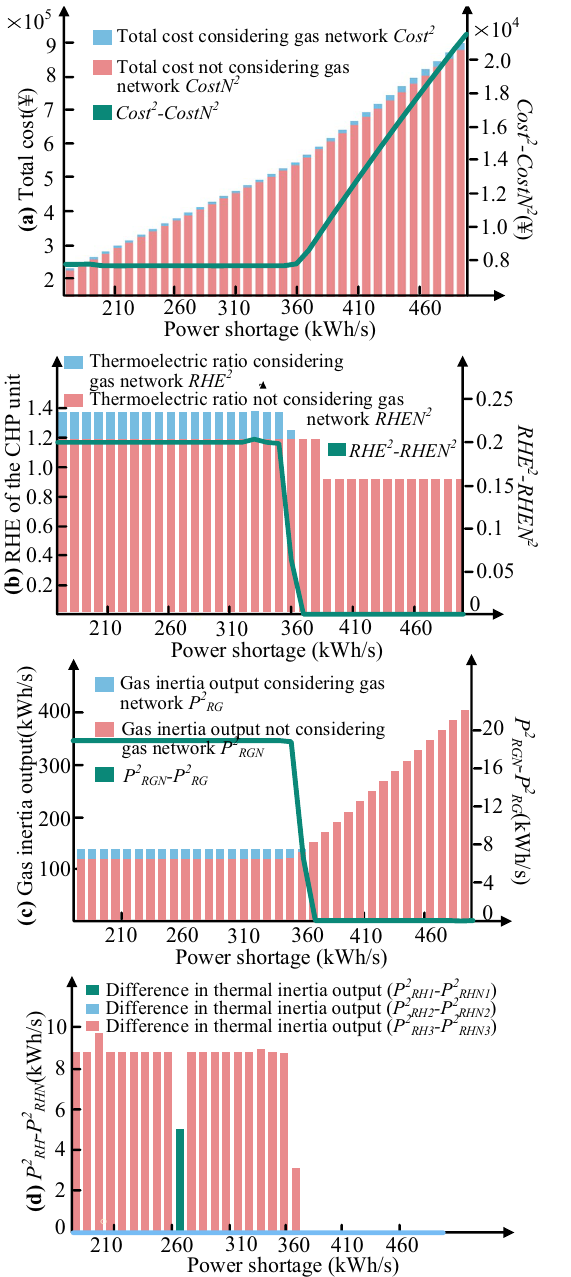
Fig. 11 Comparison results with power shortages at L 2